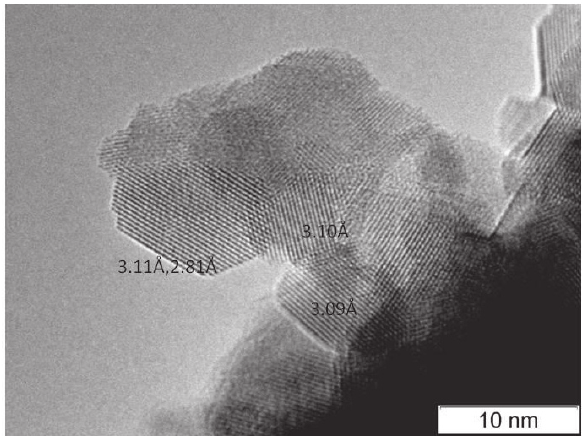
Figure 5: Typical high resolution TEM image of nanodomains in Ce Zr O sample. 0.5 0.5 2